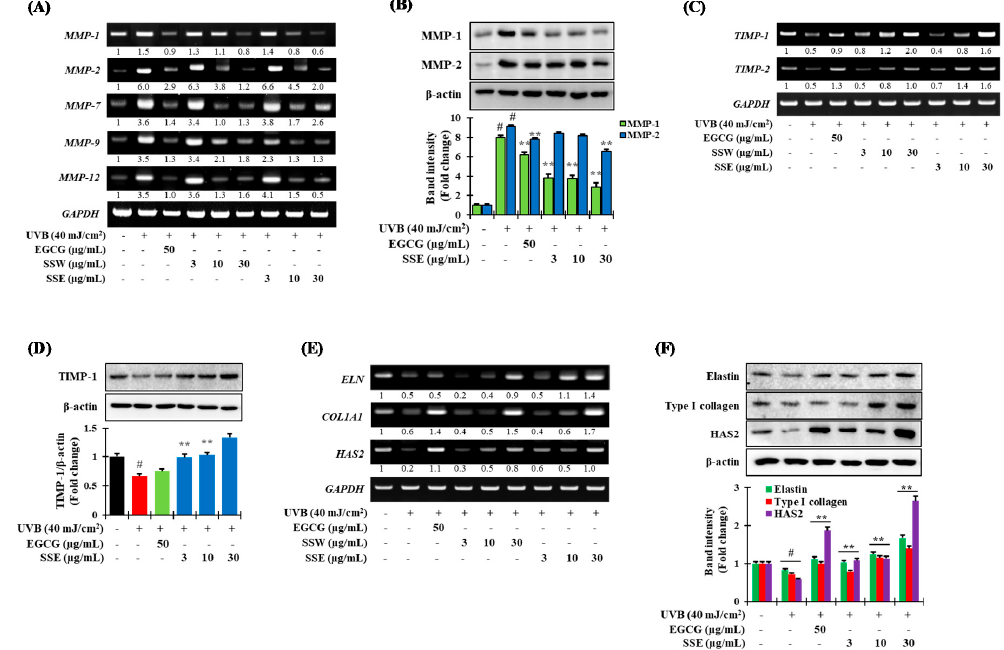
Figure 3. E ff ects of aging-related biomarkers by SSE. The e ff ects of SSE on the regulation of ( A ) the mRNA expression and ( B ) the protein level of MMPs; ( C ) the mRNA expression and ( D ) the protein level of tissue inhibitors of matrix metalloproteinases (TIMPs); ( E ) the mRNA expression and ( F ) the protein level of elastin (ELN), type I collagen (COL1A1) and hyaluronan synthase 2 (HAS2) induced by UVB (40 mJ / cm 2 ) in HaCaT cells. Cells were cultured for 24 h, and then with the indicated concentration of SSW and SSE for further 12 h. Then the cells were irradiated with 40 mJ / cm 2 UVB and cultured for additional 12 h. Reverse transcription-polymerase chain reaction (RT-PCR) and western blot was mean ± SD from triplicate results. ( # p ≤ 0.01, compared with the NT; ** p ≤ 0.05, compared with